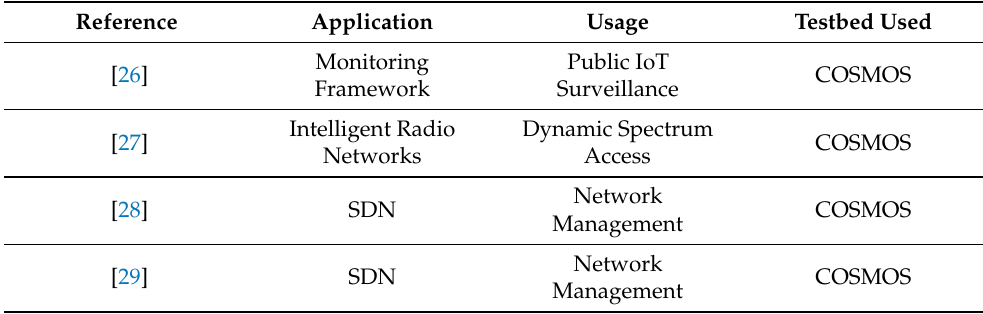
Table 2. Experiments by other researchers on